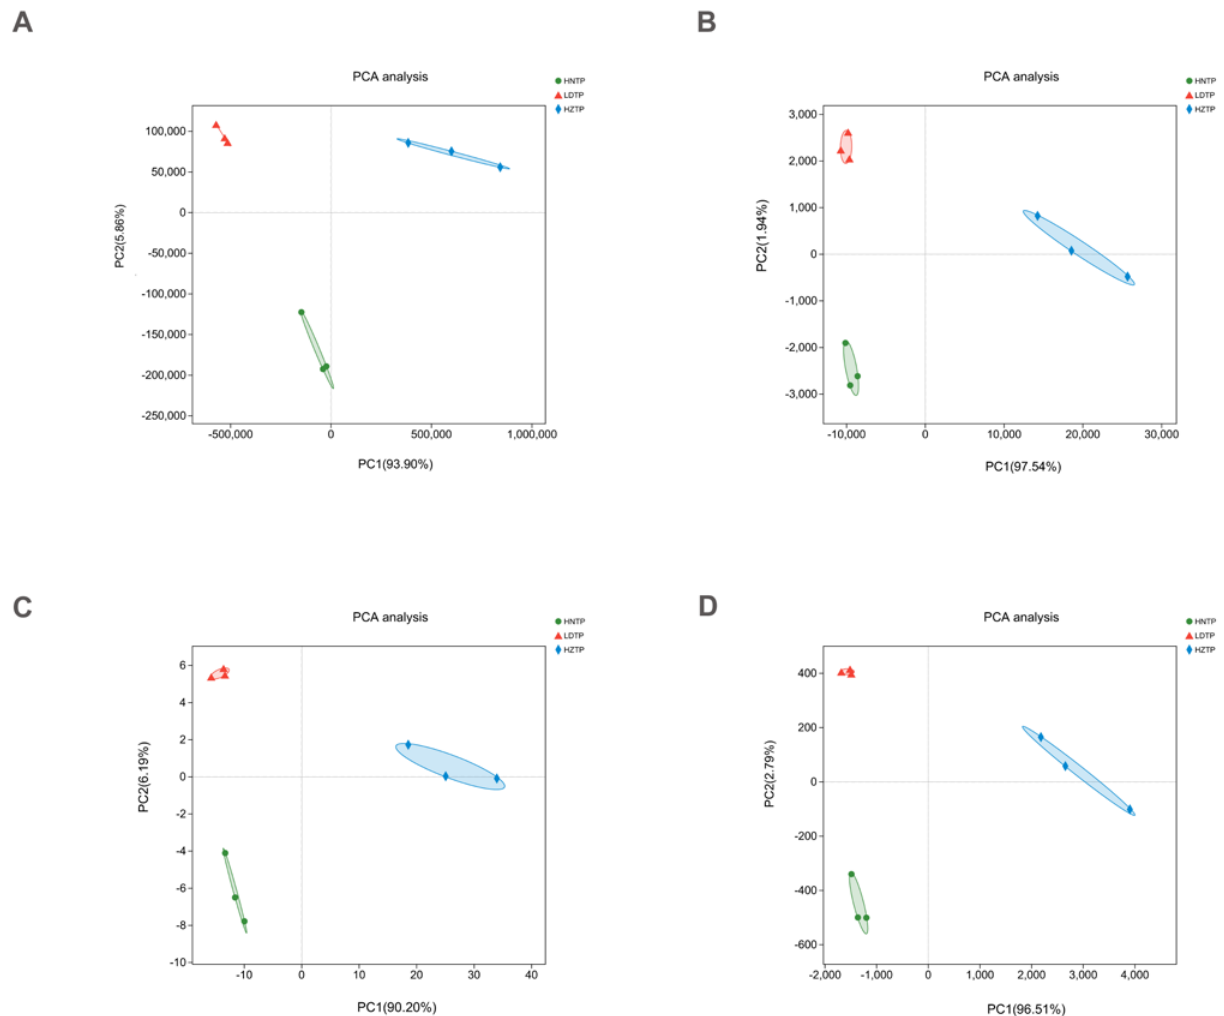
Figure 3. PCA of Tianpei samples: ( A ) PCA of NR; ( B ) PCA of COG; ( C ) PCA of KEGG; ( D ) PCA of CAZy.